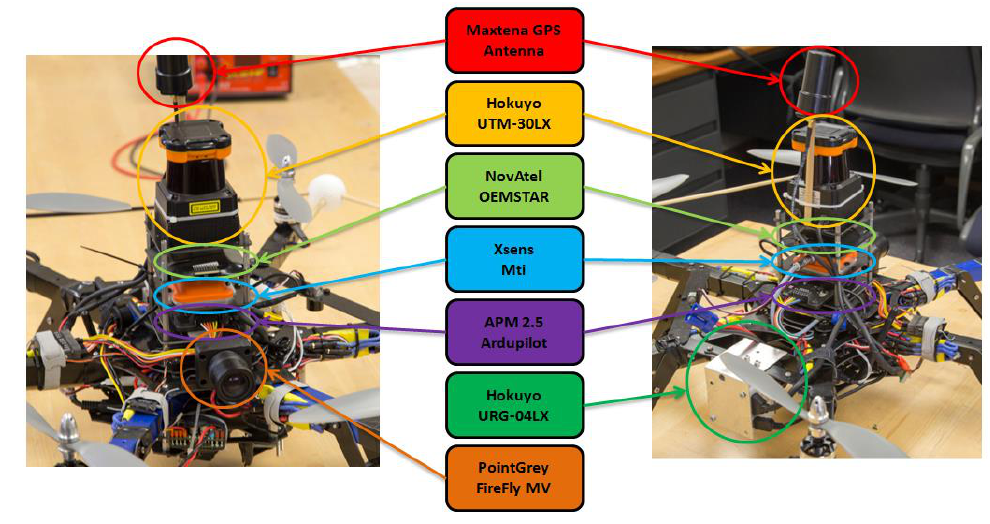
Figure 4. Sensor locations on board the 3DR hexacopter.